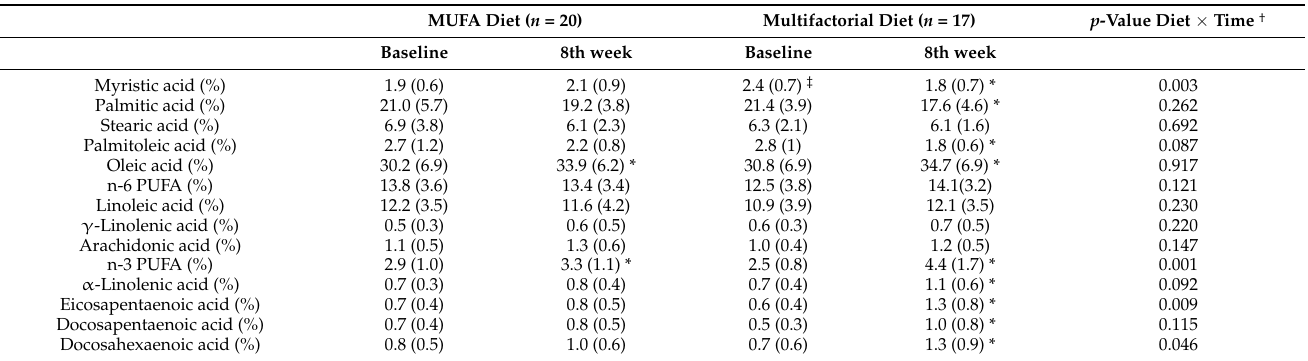
Table 2. Fatty acid composition of serum triglycerides at baseline and after the 8-week intervention in participants who completed the